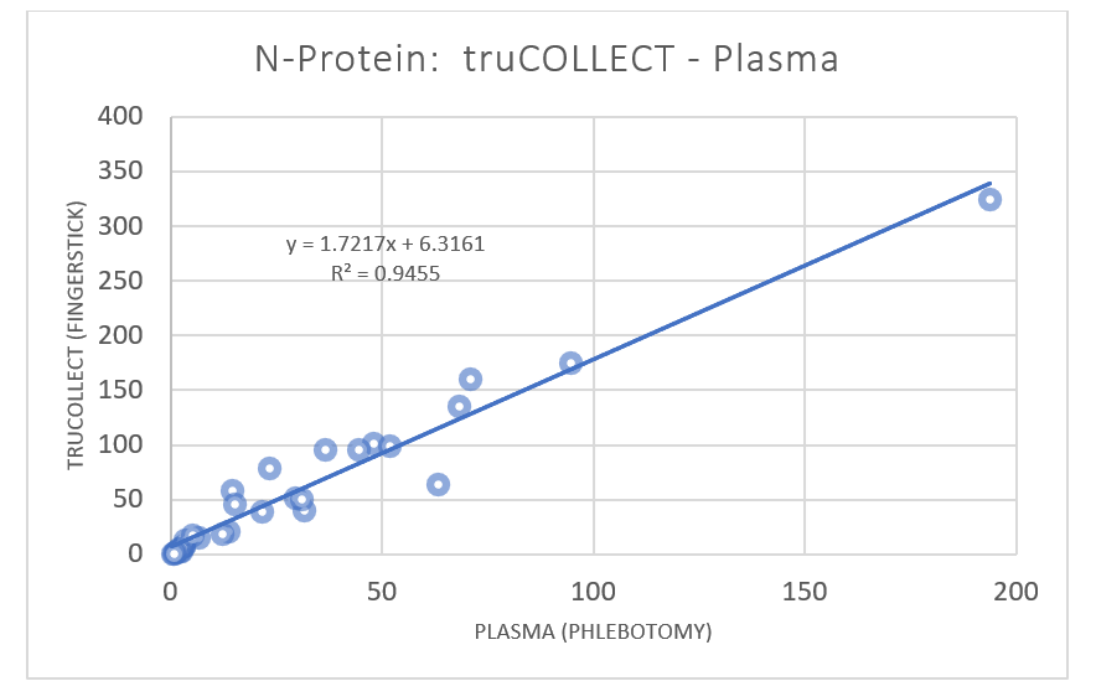
Figure 6. Correlation of SARS-CoV-2 N-protein antibodies in paired plasma and truCOLLECT sam- ples. A comparison of absorbance measurements from 32 donors using the SARS-CoV-2 Nucleocap- sid protein ELISA kit (Abcam). Capillary fingerstick blood collected with truCOLLECT (Y-axis), and Venipuncture derived plasma (X-axis) are examined; r 0.972; 95% CI [0.94, 0.99].